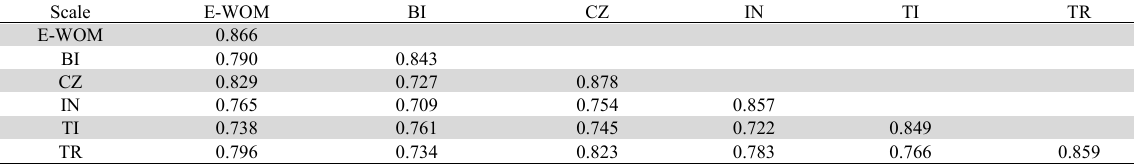
Discriminant Validity Establishment based on Fornell-Larcker Criterion